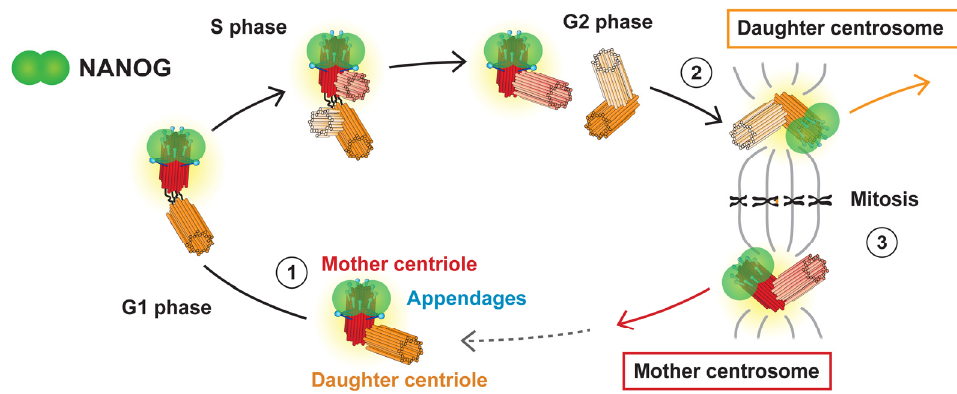
Figure 10. Schematic summarizing the observed spatiotemporal localization of NANOG/NANOGP8 at centrosome during the cell cycle. NANOG (green) is present at the same time as mother centriole appendages: (1) During interphase, NANOG protein colocalizes with the distal region of the mother centriole (red), which carries distal and subdistal appendages (blue). (2) NANOG signal as well as the distal appendages also later appear on the initially daughter centriole (orange) during the G2/mitosis transition. (3) The centrosome duplication cycle results in two daughter cells with different ages of centrosomes, mother and daughter centrosomes, both having the older, mother centriole marked with NANOG protein.